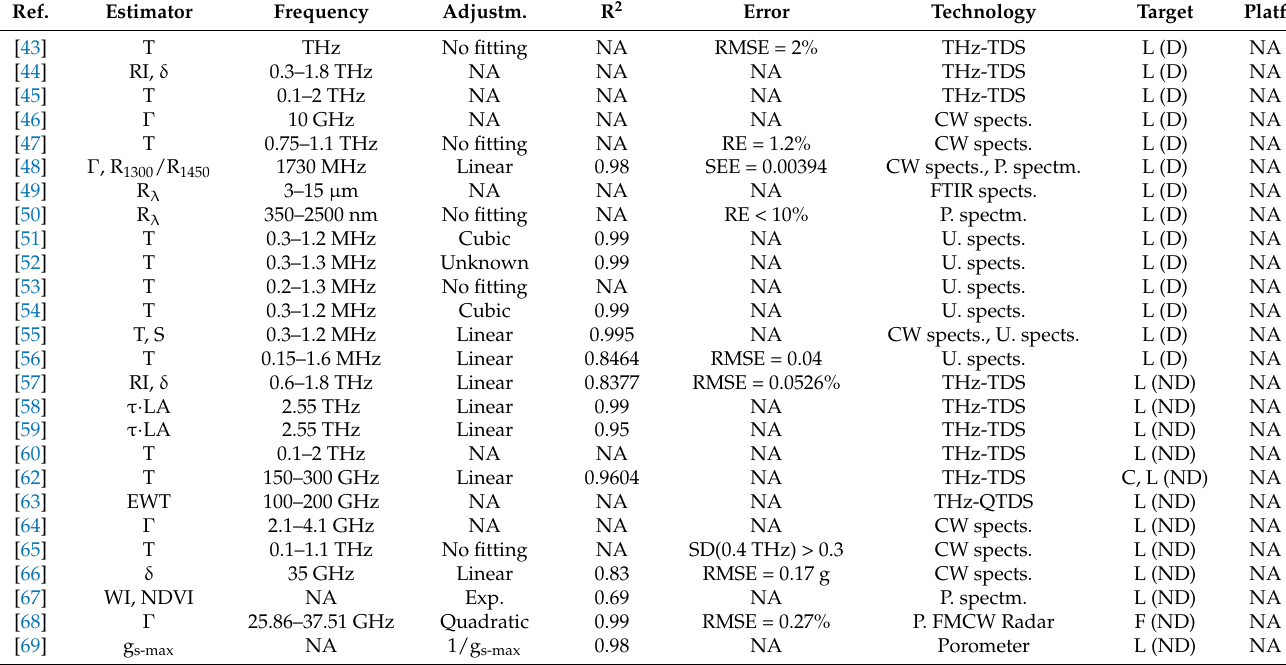
Table 4. Summary of the estimators used in leave techniques together with the operating frequency, type of adjustment, R 2 , estimation error, technology, target and sensor platform.